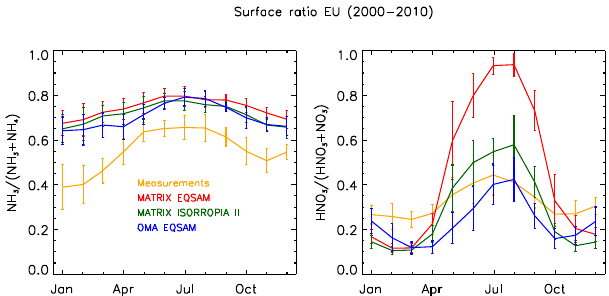
Figure 9. The 2000–2010 mean partitioning ratio annul cycle over Europe, error bars represent ± 1 standard deviation. Measurements are in orange, MATRIX-EQSAM is in red, MATRIX-ISORROPIA II is in green, and OMA-EQSAM is in